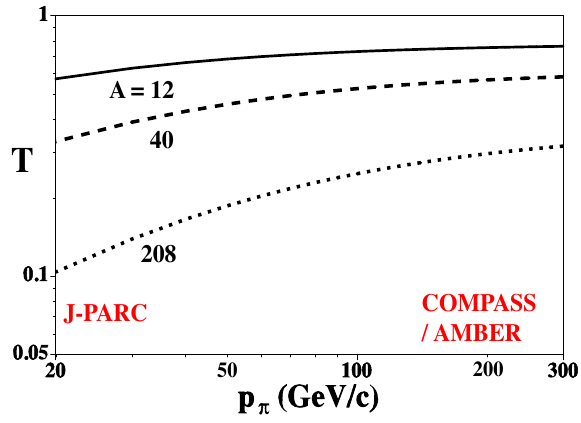
Figure 7. Color transparency in 2 → 3 process π − A → π − π + A ∗ . Taken from